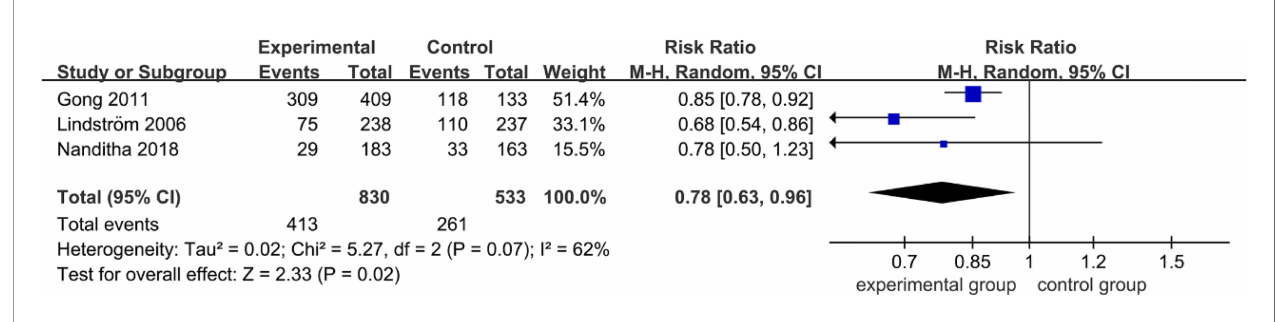
FIGURE 4 | Forest plot of diabetes incidence in extended follow-up studies.